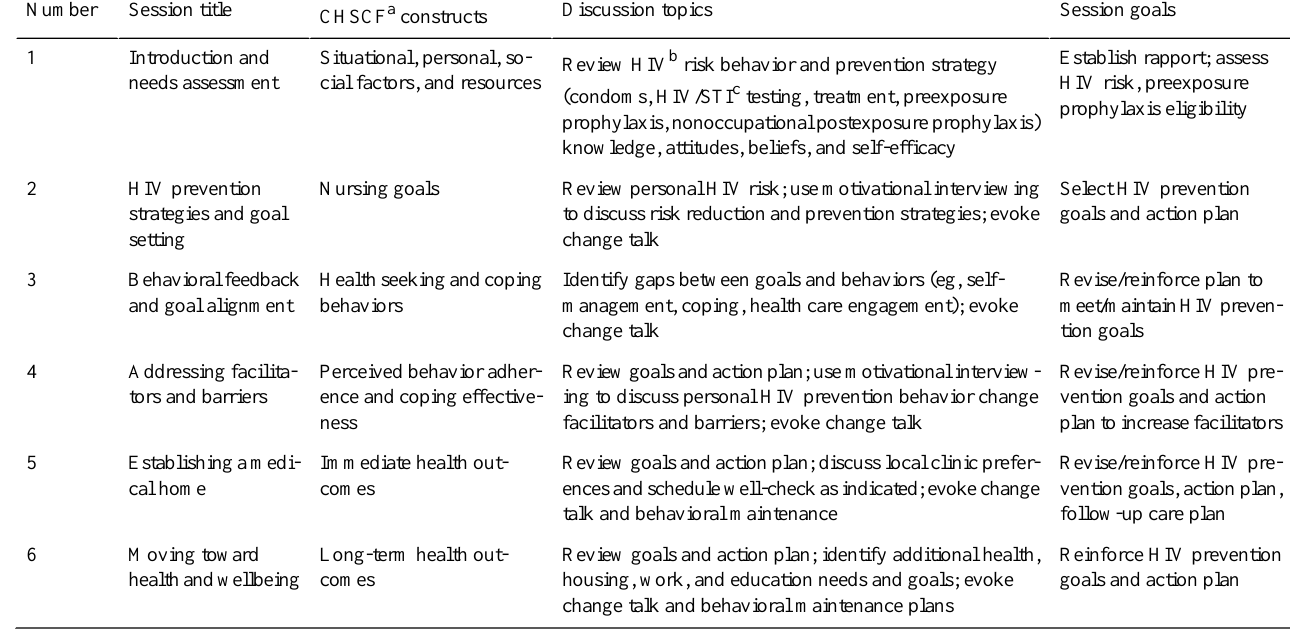
Table 1. Come As You Are session